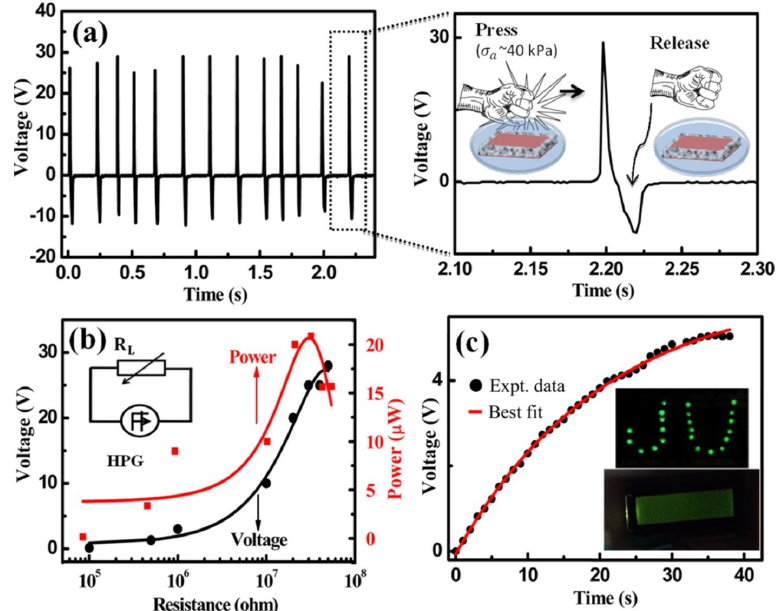
Figure 12. ( a ) Open-circuit output voltage of a PDMS/Cellulose/MWCNT based nanogenerator. ( b ) Voltage and instantaneous power change with respect to the load resistance (inset shows the corresponding circuit diagram). ( c ) Charging a capacitor from repeated human hand punching and releasing. LEDs and LCD screen (shown in inset of c ) are lighted directly and from the charged capacitor, respectively. Reprinted with permission from [78] c (cid:13) 2016 ACS